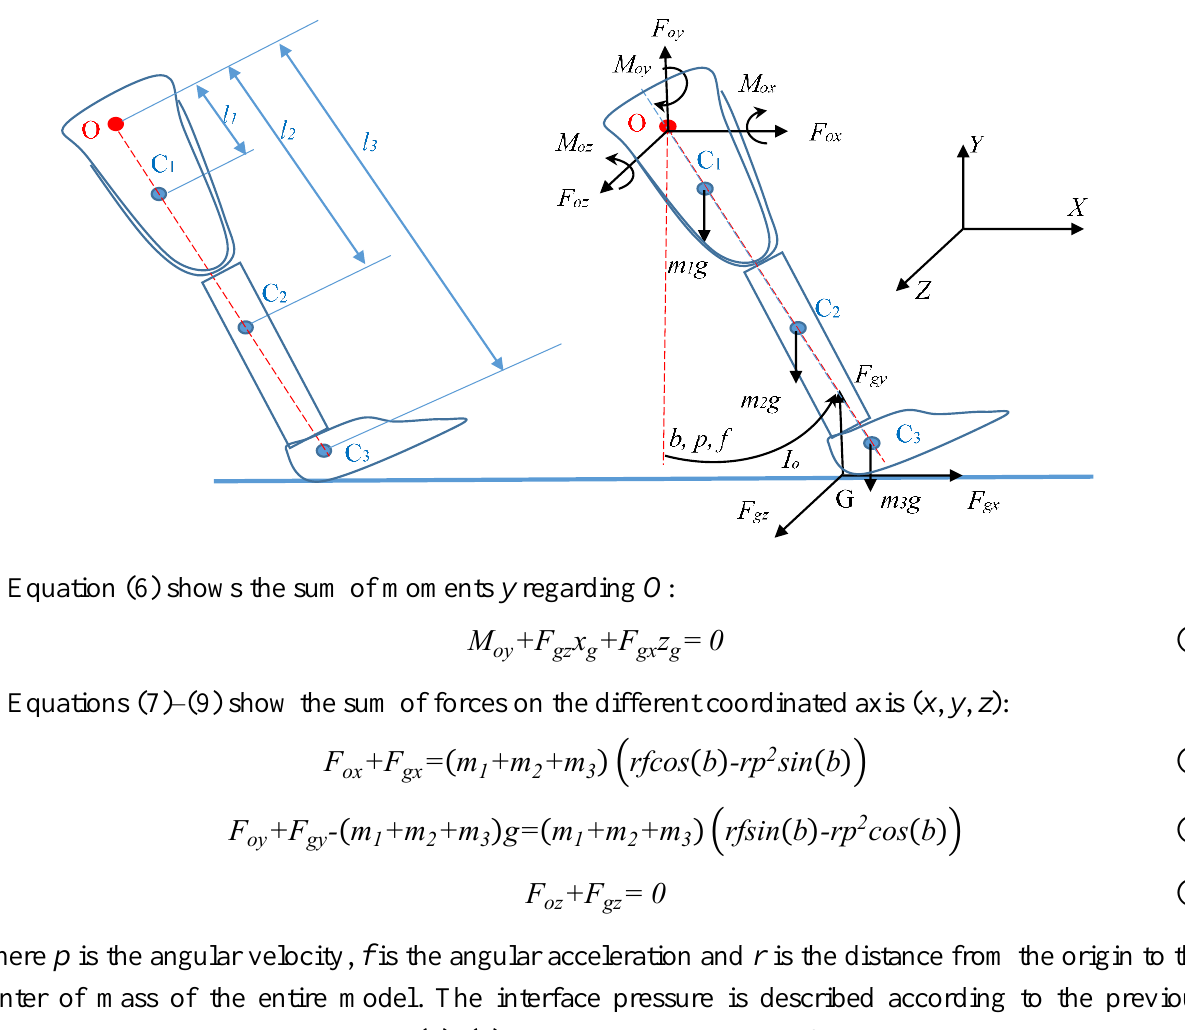
Figure 4. Free body diagram of forces and moments during prosthetic leg heel strike